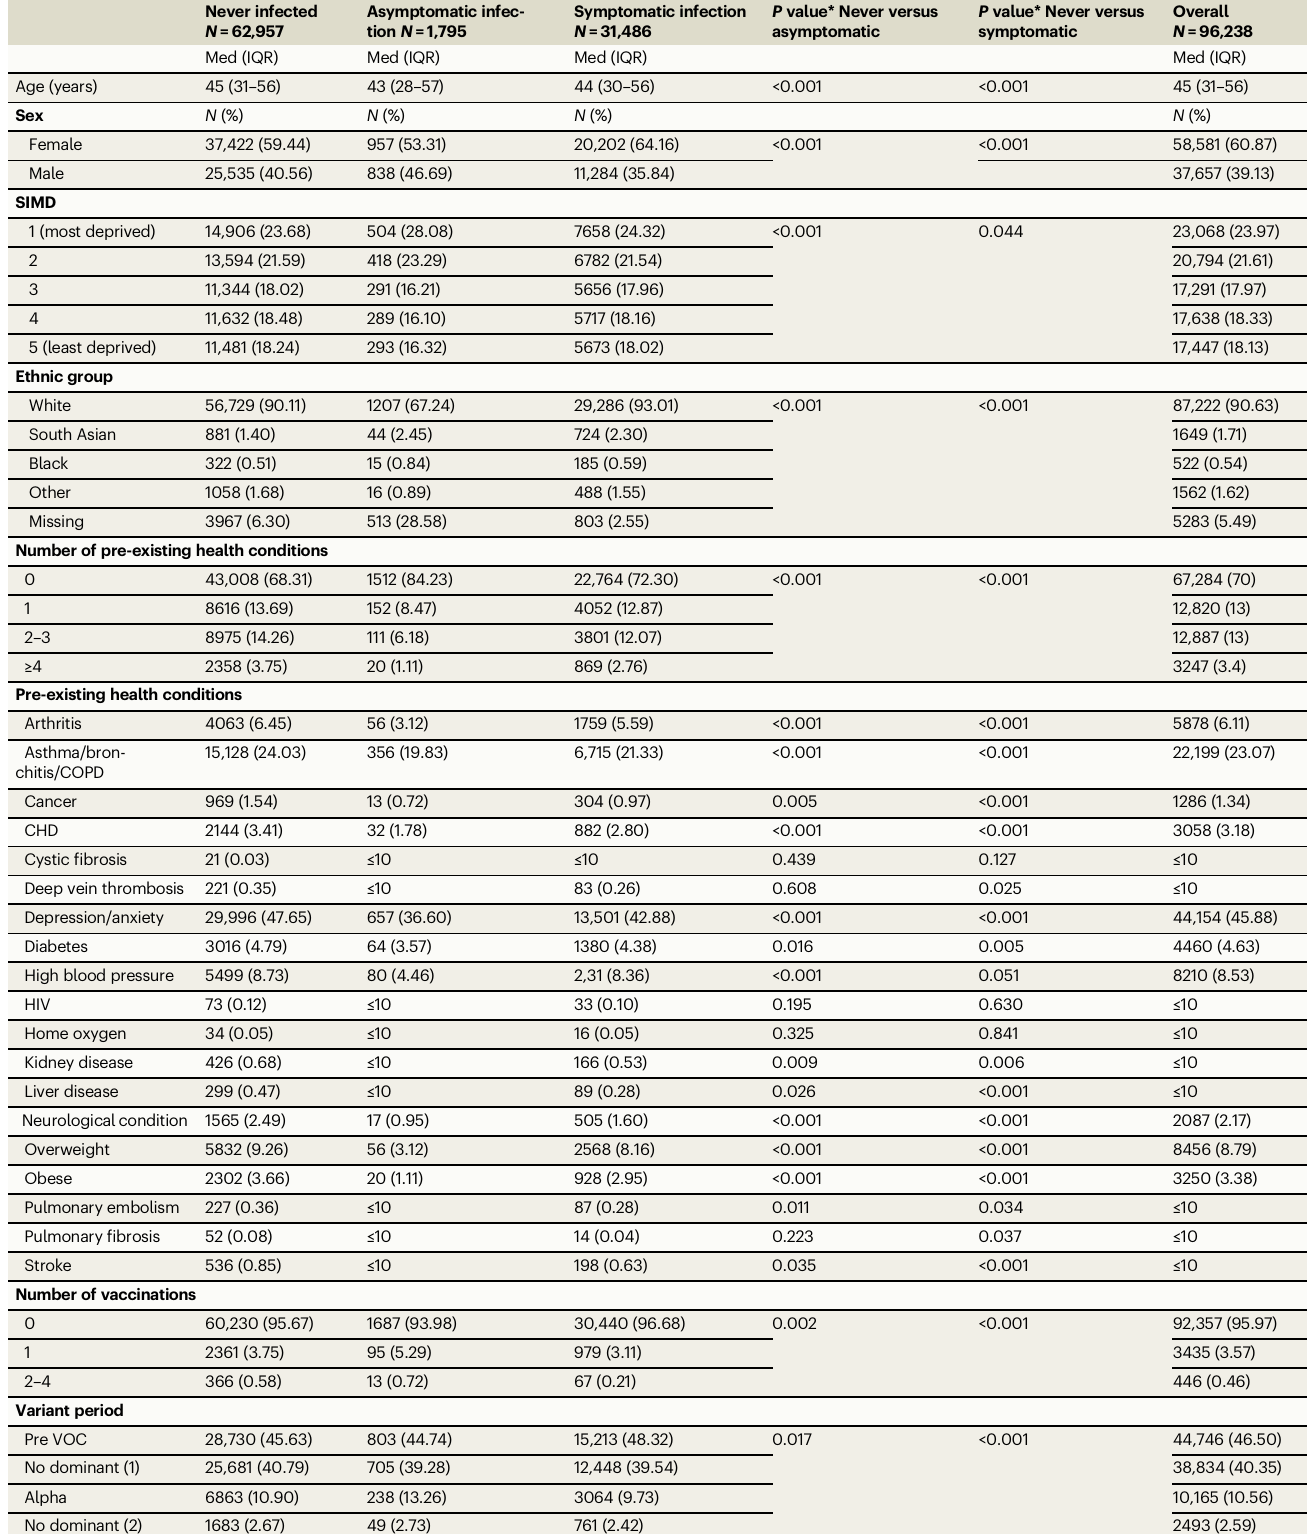
Table 1 | Characteristics of study participants by infection status and symptomatology Never infected N